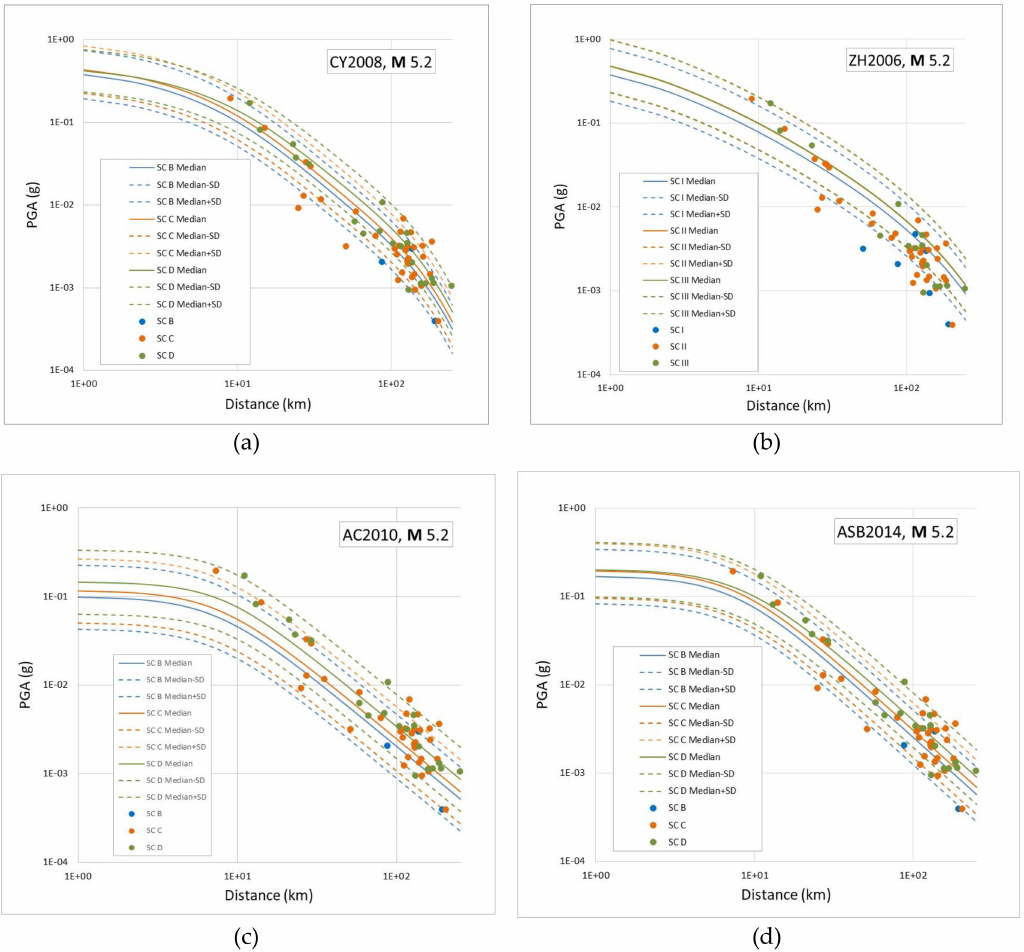
Figure 12. Comparison of the data from M5.2 earthquakes with the 16 th , 50 th (median) and 84 th percentile estimations from the four ground motion prediction models used in the GMPE logic